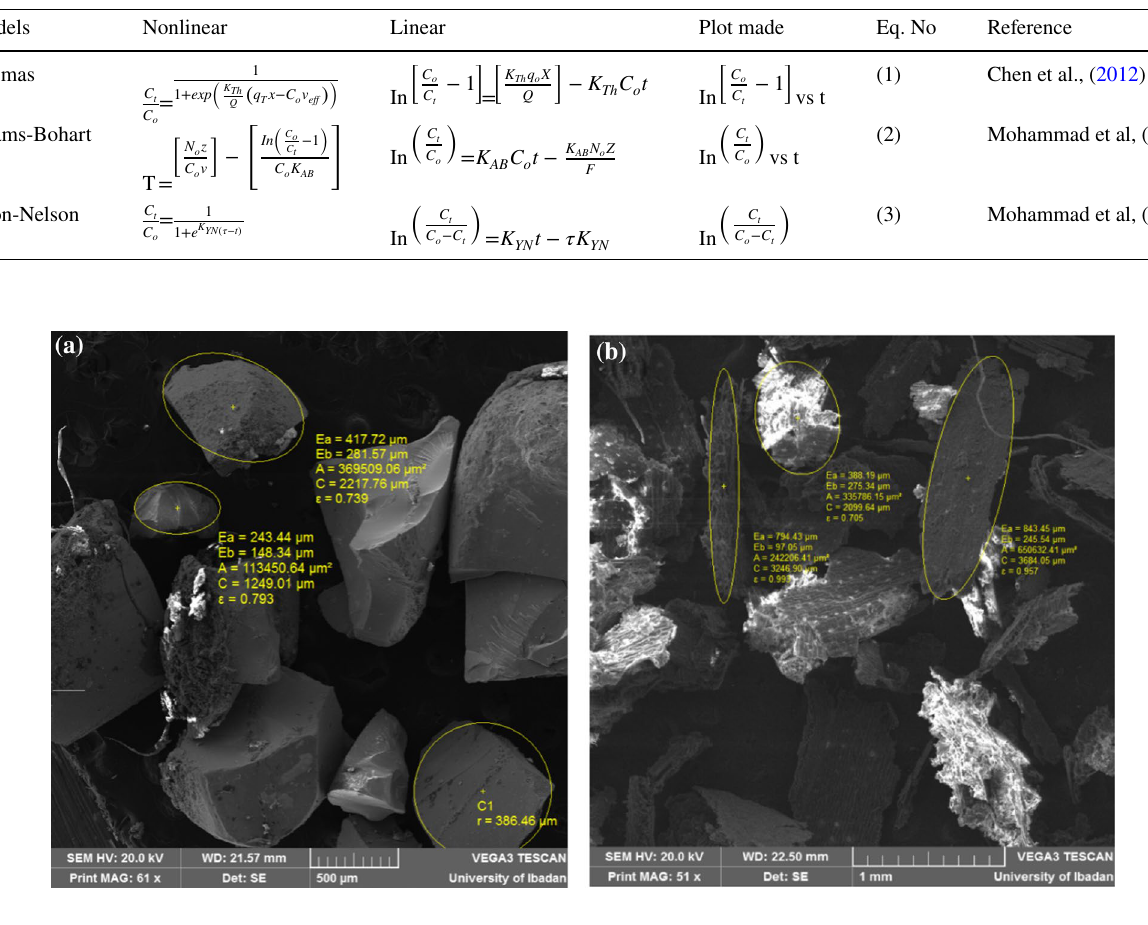
Fig. 1 SEM images of a silver nanoparticles b silver-maize leaf